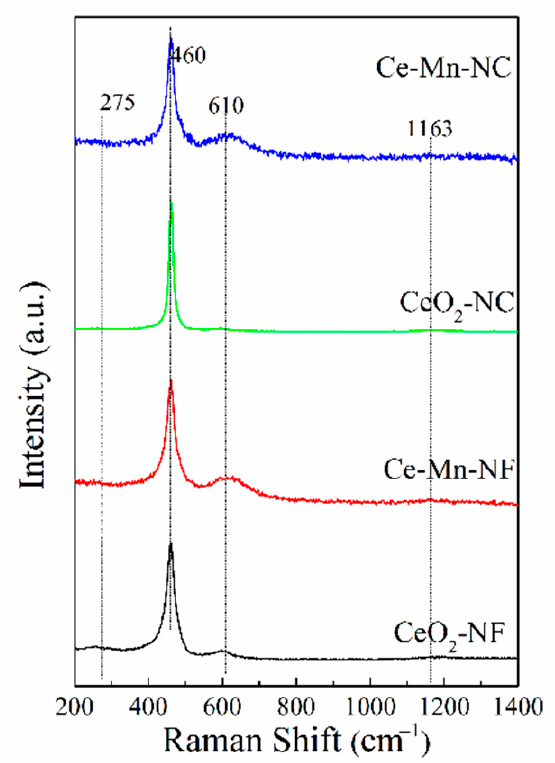
Figure 3. Room temperature visible Raman spectra of all the samples. Table 2. Physical and chemical properties of all samples.